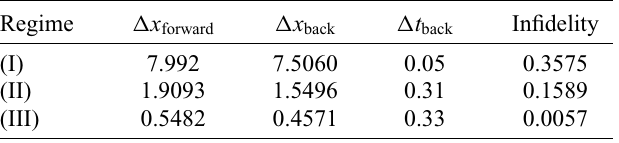
TABLE III. Best dressed JMJ model strategy parameters and their corresponding infidelities obtained from scans over (cid:3) x (cid:3) t (cid:3) x forward , back , and back . The corresponding profiles are shown in Fig. 1 in the main